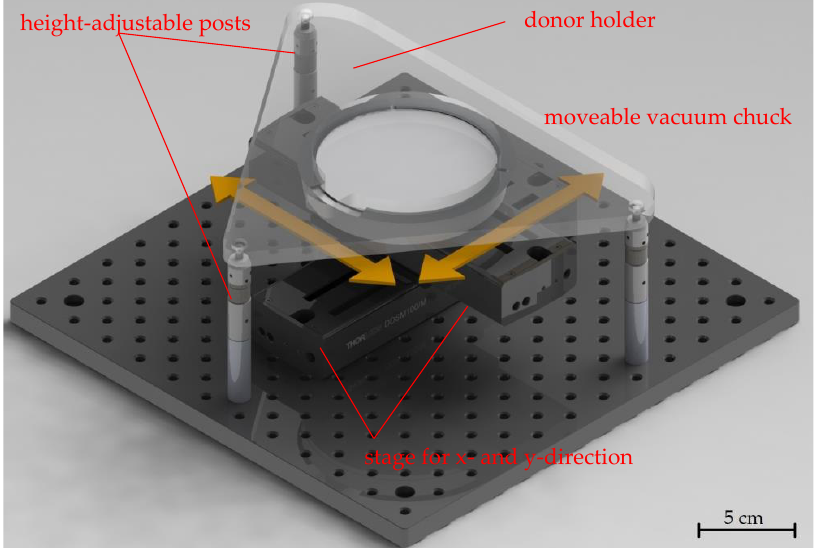
Figure 2. Annotated image of the custom-built LIFT stage with arrows indicating the axis directions for the motion of the vacuum chuck. The receiver was placed on the chuck, while the donor was held by the structure above. The distance between the donor and receiver could be adjusted using three height-adjustable posts. The parallelism between the substrates was secured and the distance could be kept constant during the LIFT